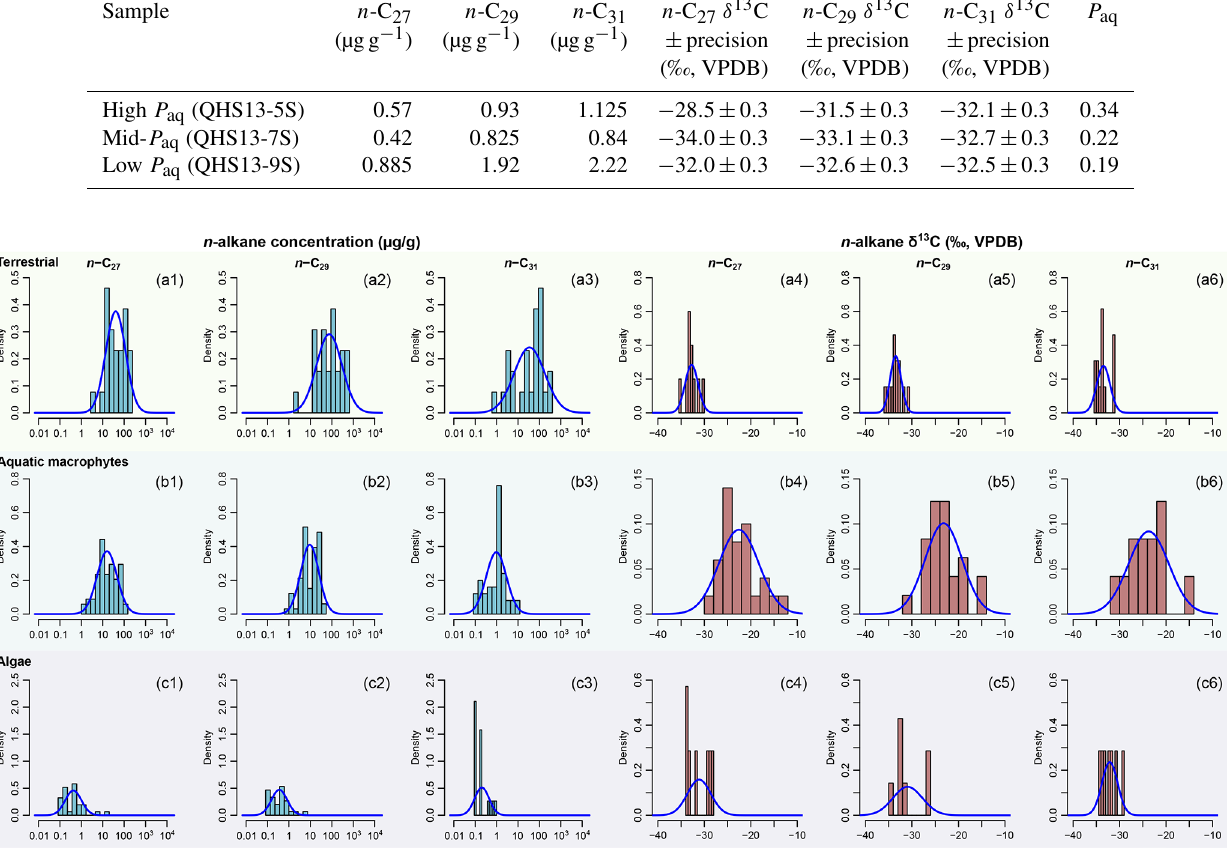
Figure 2. Empirical data of per sample n -alkane concentrations (µgg − 1 of dried sample, blue histograms) and δ 13 C (‰, VPDB, red histograms) of n -C 27 , n -C 29 , and n -C 31 alkanes and their corresponding prior distributions (blue Gaussian curve overlays) of published plants in the terrestrial, aquatic macrophyte, and algae sources; raw data are compiled in supplementary data EA-2 (Yang, 2022). Estimated prior parameters of each source, including the means and variance–covariance matrices, are reported in Tables S1 and